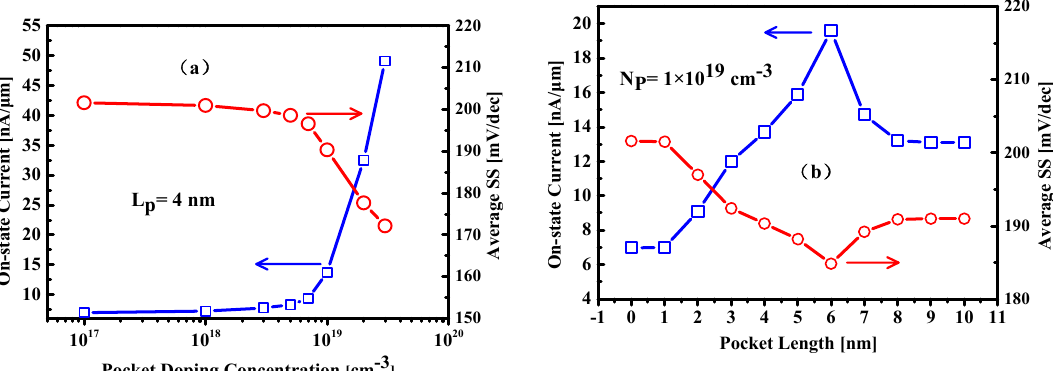
Figure 8. Plot of simulated on-state current and average SS as functions of ( a ) pocket doping concentration and ( b ) pocket length. The N P = 1 × 10 17 cm − 3 and L P = 0 nm correspond to the case of HTFET without SP structure.